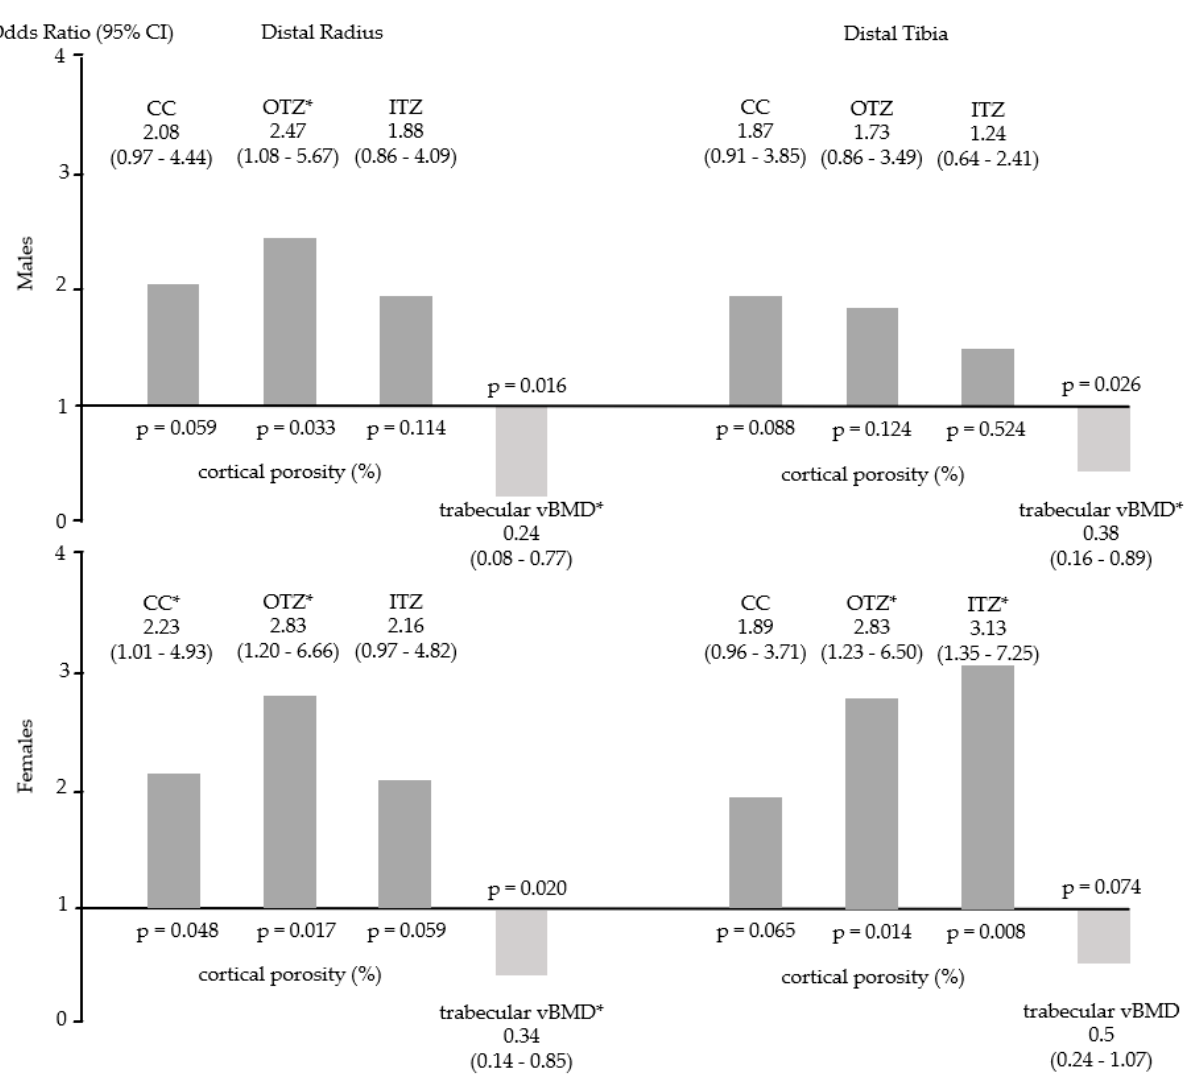
Figure 3. Odds ratio (OR) for fracture (mean and 95% Confidence Intervals, CI) for porosity of the compact appearing cortex (CC), outer and inner transitional zones (OTZ, ITZ) and trabecular volumetric bone mineral density (vBMD) at distal radius and distal tibia in males and females. * = significant p -values.